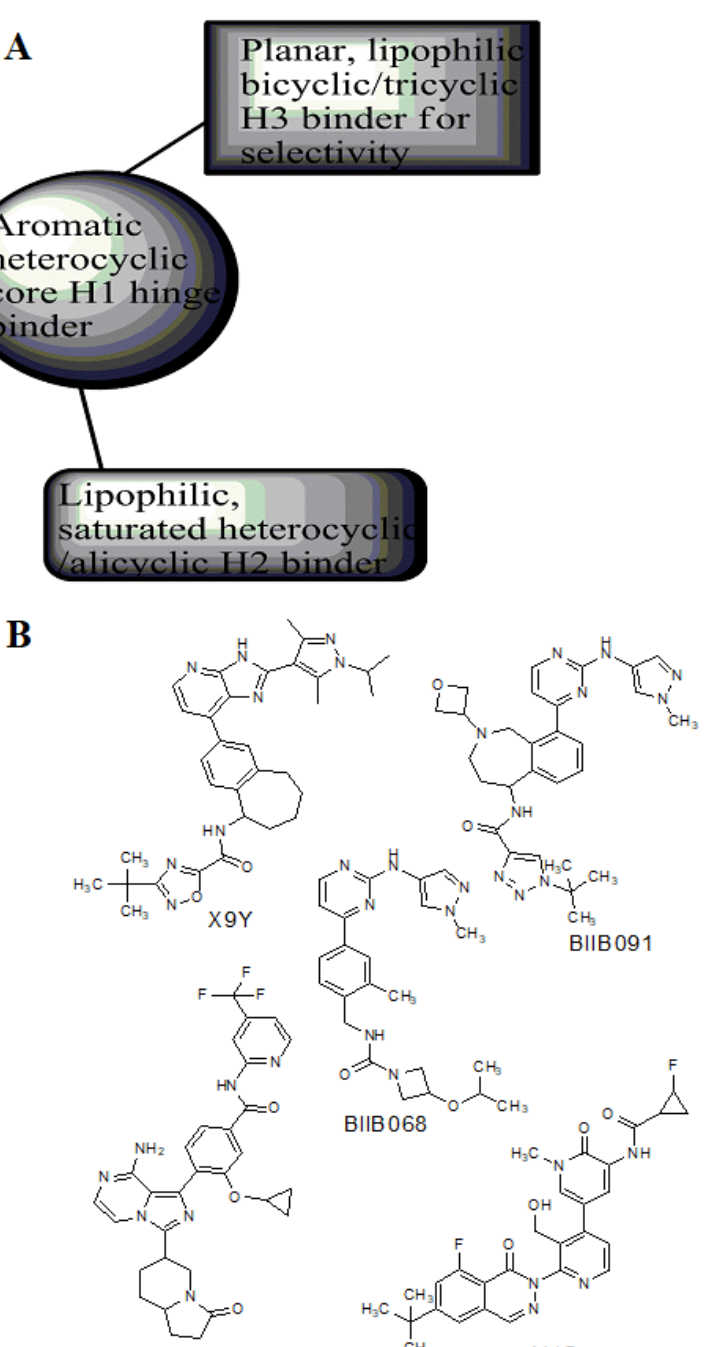
Figure 10. ( A ) Complementary structural features of non-covalent inhibitors of BTK-kinase domain, ( B ) structures of novel non-covalent inhibitors of BTK deposited in PDB.